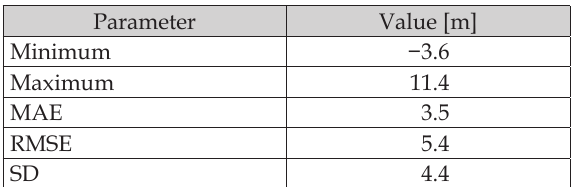
Table 1. Results of assessing the accuracy of DEM by control points.